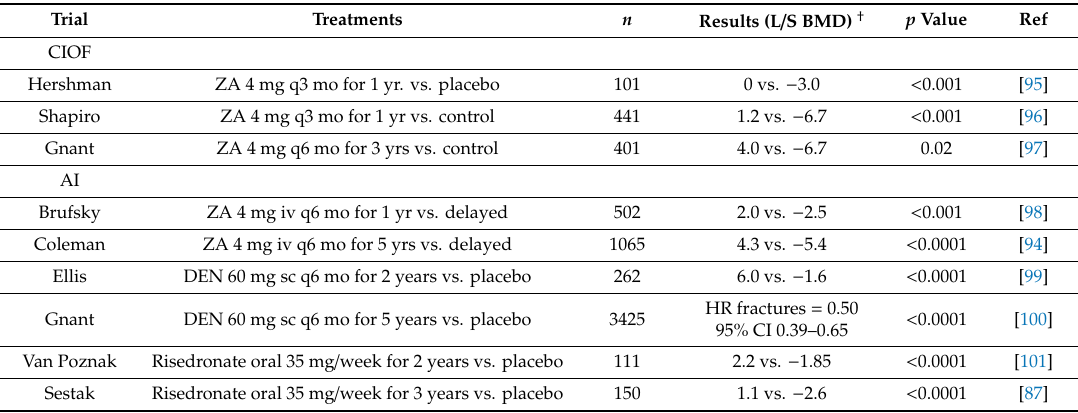
Table 4. Major randomized trials for bone